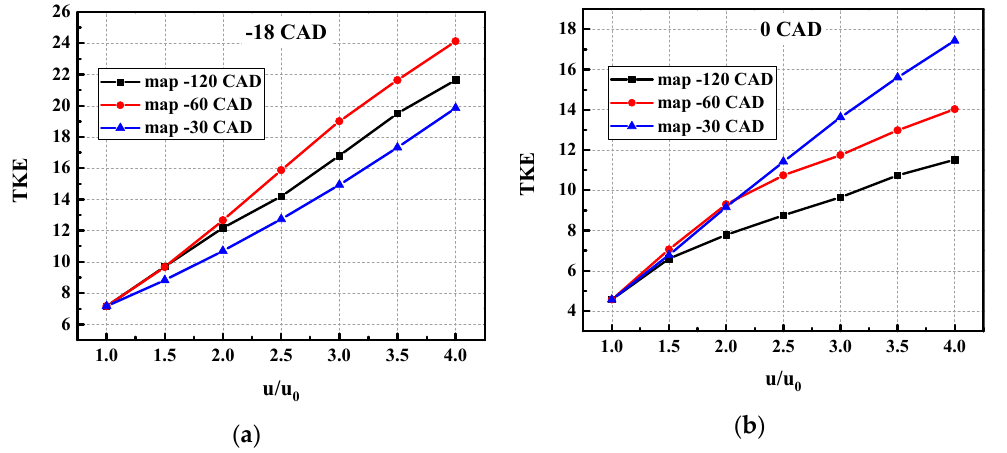
Figure 5. Values of TKE for di ff erent u / u 0 at the instant of ( a ) − 18 CAD aTDC and ( b ) TDC. Table 3. Operating parameters in the analysis of the effects of turbulence intensity. Parameters